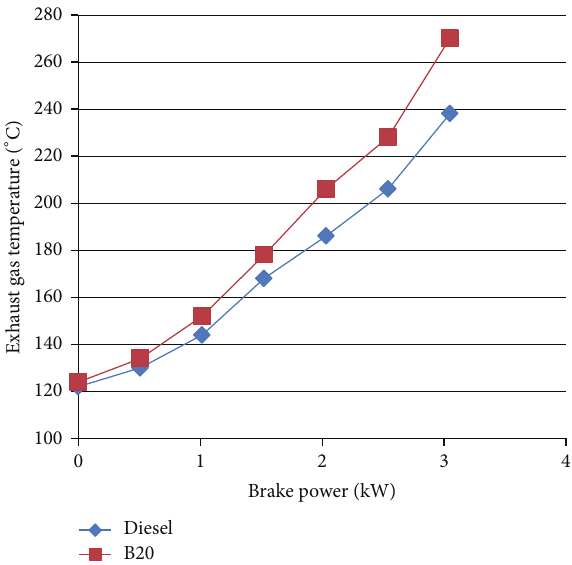
Figure 10: Brake specific fuel consumption versus brake power.